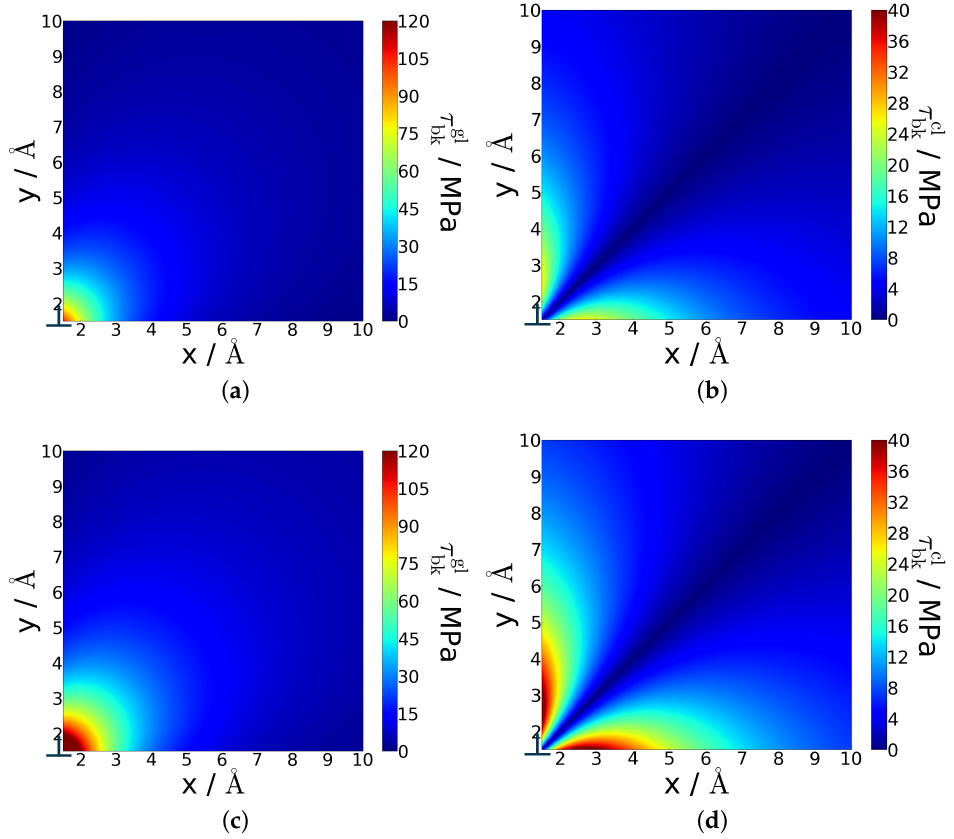
Figure 3. Back stresses for dislocation glide τ gl and dislocation climb τ cl with respect to the distance bk bk between one atom and an edge dislocation core. The x -axis and y -axis represent the glide and climb directions, respectively. The plotted range in x- and y-direction is from 1.5 Å to 10 Å: ( a , b ) for Re; and ( c , d ) for W. Note the different scales on the colorbars for glide and climb back stresses,